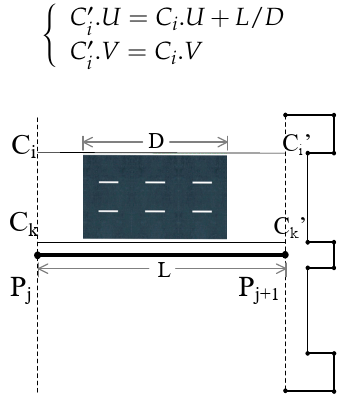
Figure 8. Roadbed texture mapping.